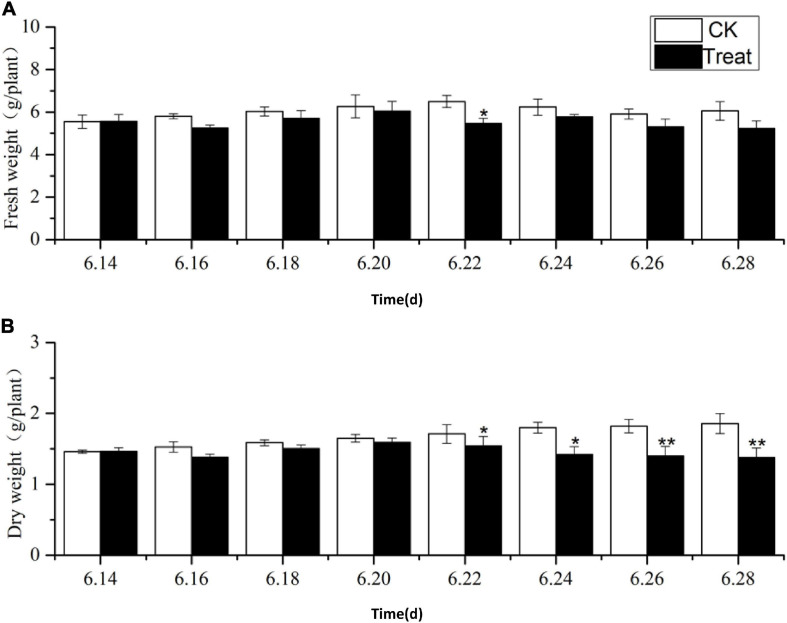
Effects of cold stress on fresh weight and dry weight of ginseng during the flowering stage. The X axis represents the sampling time. (A) Represents the change of fresh weight under cold stress. (B) Represents the change of dry weight under cold stress. *p < 0.05 and **p < 0.01, compared with control group. Vertical bars indicate the mean value ± standard deviation from three independent experiments. The same below.